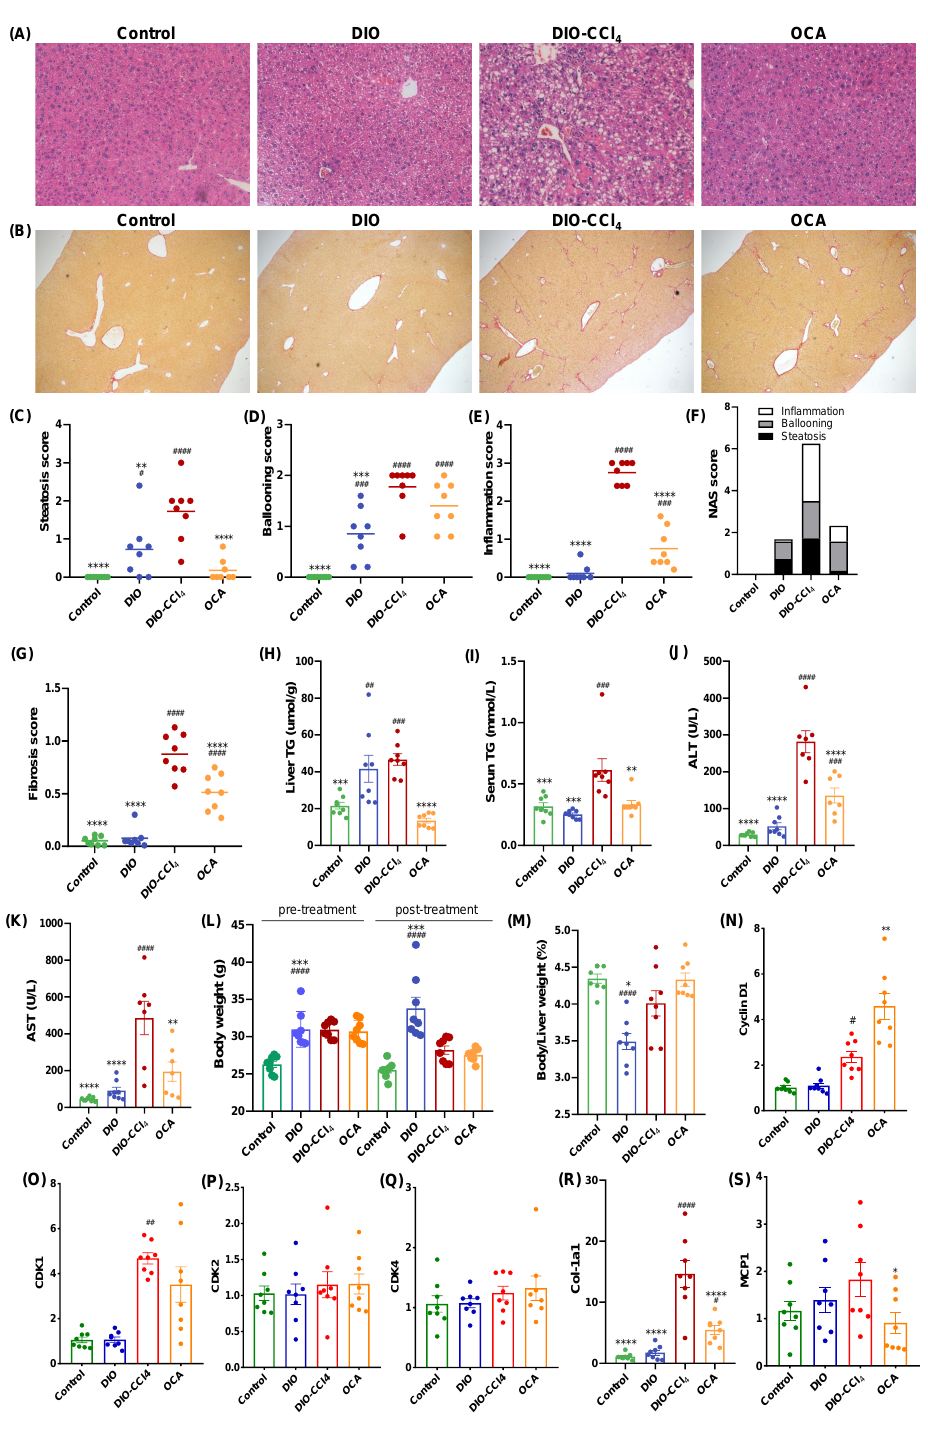
Figure 1. OCA attenuates hepatic steatosis, inflammatory responses and fibrosis in DIO-CCl 4 mice. ( A ) Representative Hematoxylin and eosin (HE) staining results (magnification × 200). ( B ) Representative Sirius red staining results (magnifica- tion × 50). ( C – F ) Histological assessment of steatosis score, ballooning score, inflammation score and the NAFLD activity score (NAS). ( G ) Quantification of Sirius Red-positive area. ( H ) Liver TG was detected. ( I – K ) The serum TG concentration, ALT and AST was measured. ( L ) Body weight and ( M ) liver/body ratio. ( N – S ) Gene expression assessment of cyclin D1, CDK1, CDK2, CDK4, Col-1a1 and MCP-1 in livers. * p < 0.05, ** p < 0.01, *** p < 0.005 and **** p < 0.001 vs. DIO-CCl 4 group; # p < 0.05, ## p < 0.01, ### p < 0.005 and #### p < 0.001 vs. Control